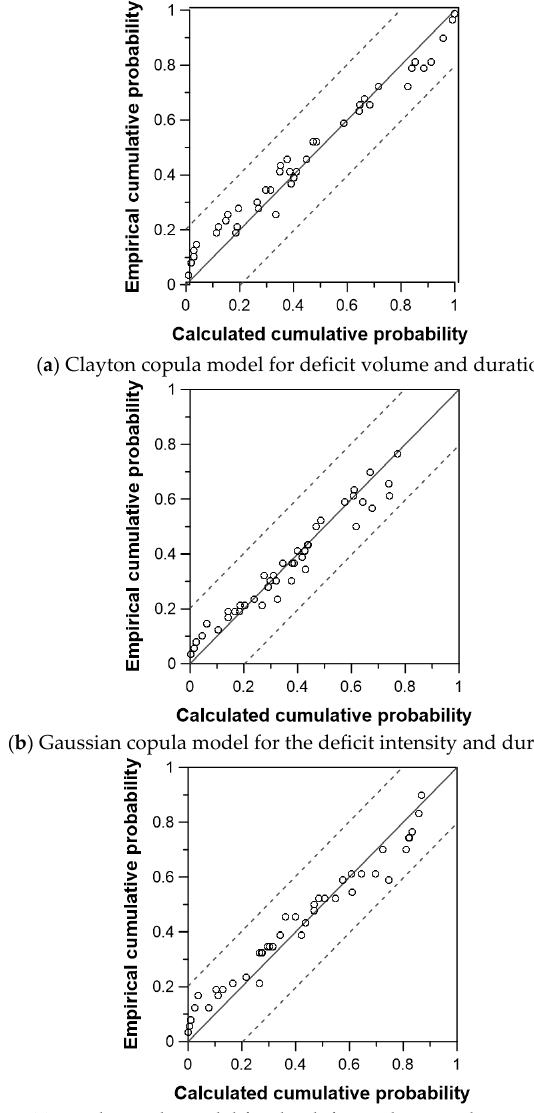
Figure 6. K-plots and K–S test criteria for three optimal copula models considered for the water deficit events observed at the Namgang